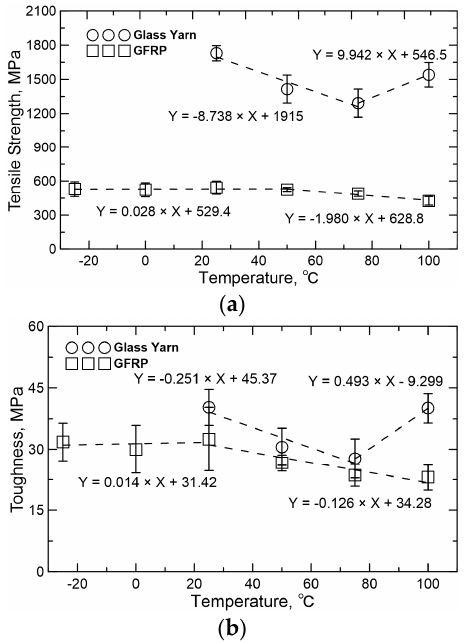
Figure 11. Temperature effect on tensile properties: ( a ) tensile strength and ( b ) toughness.